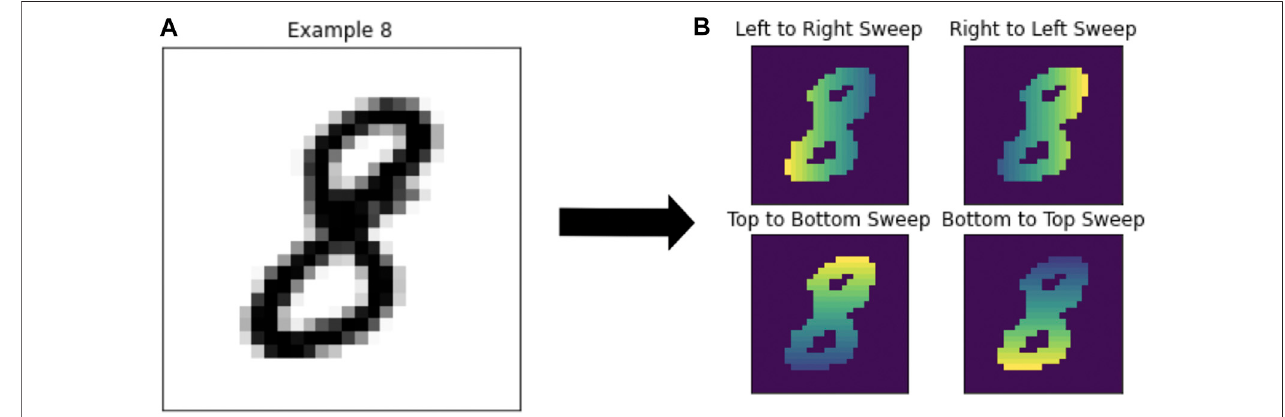
FIGURE 5 | (A) Example number 8 from the MNIST dataset. (B) The same number 8 after computing each of the four types of coordinate transforms to compute the persistence